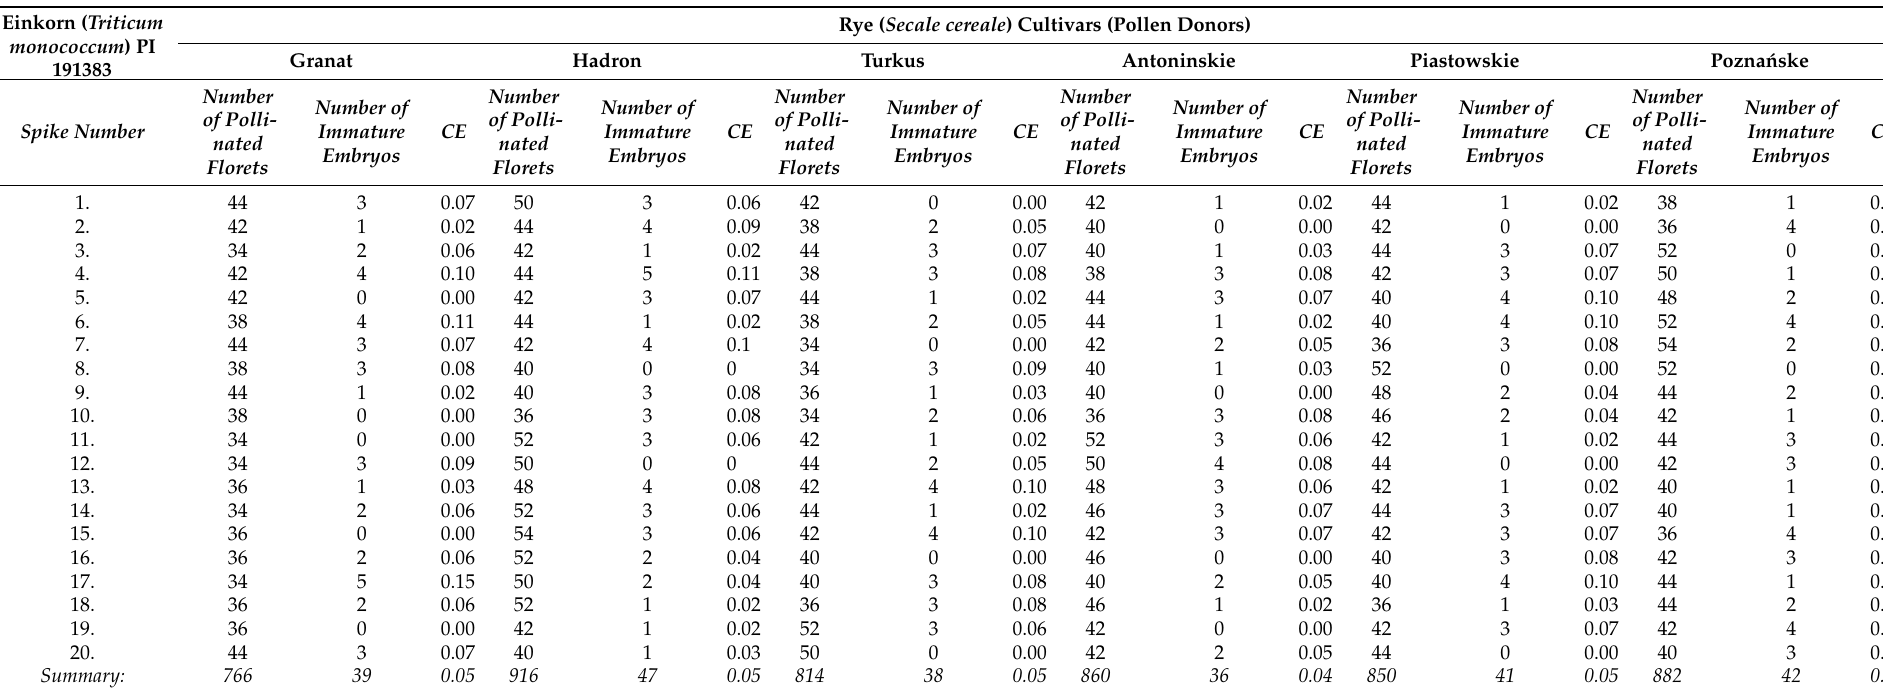
Table 2. Cross-pollination efficiency (CE) and number of pollinated flowers and immature embryos derived for plant regeneration in in vitro